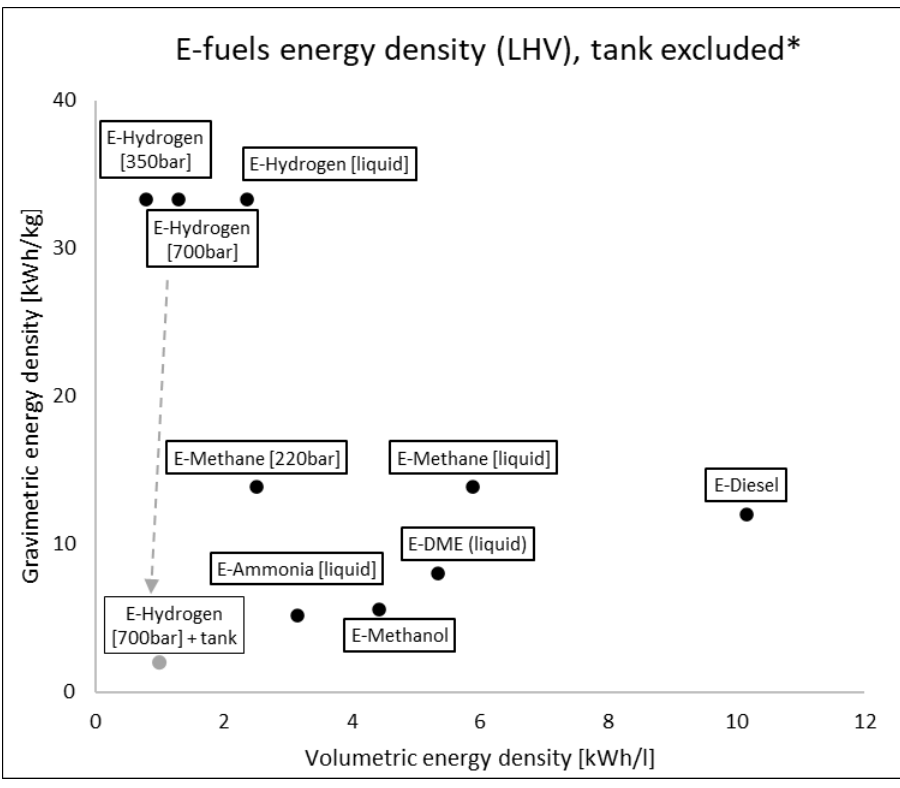
Figure 6. E-fuels gravimetric and volumetric energy density on LHV basis without containing system. * Example of tank influence only for e-hydrogen at 70 MPa.